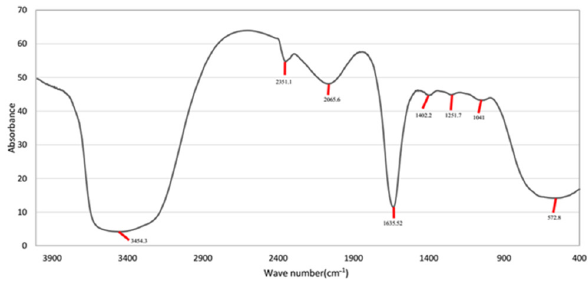
Table 3: p-Value and F ratio of the regression coefficients in the obtained